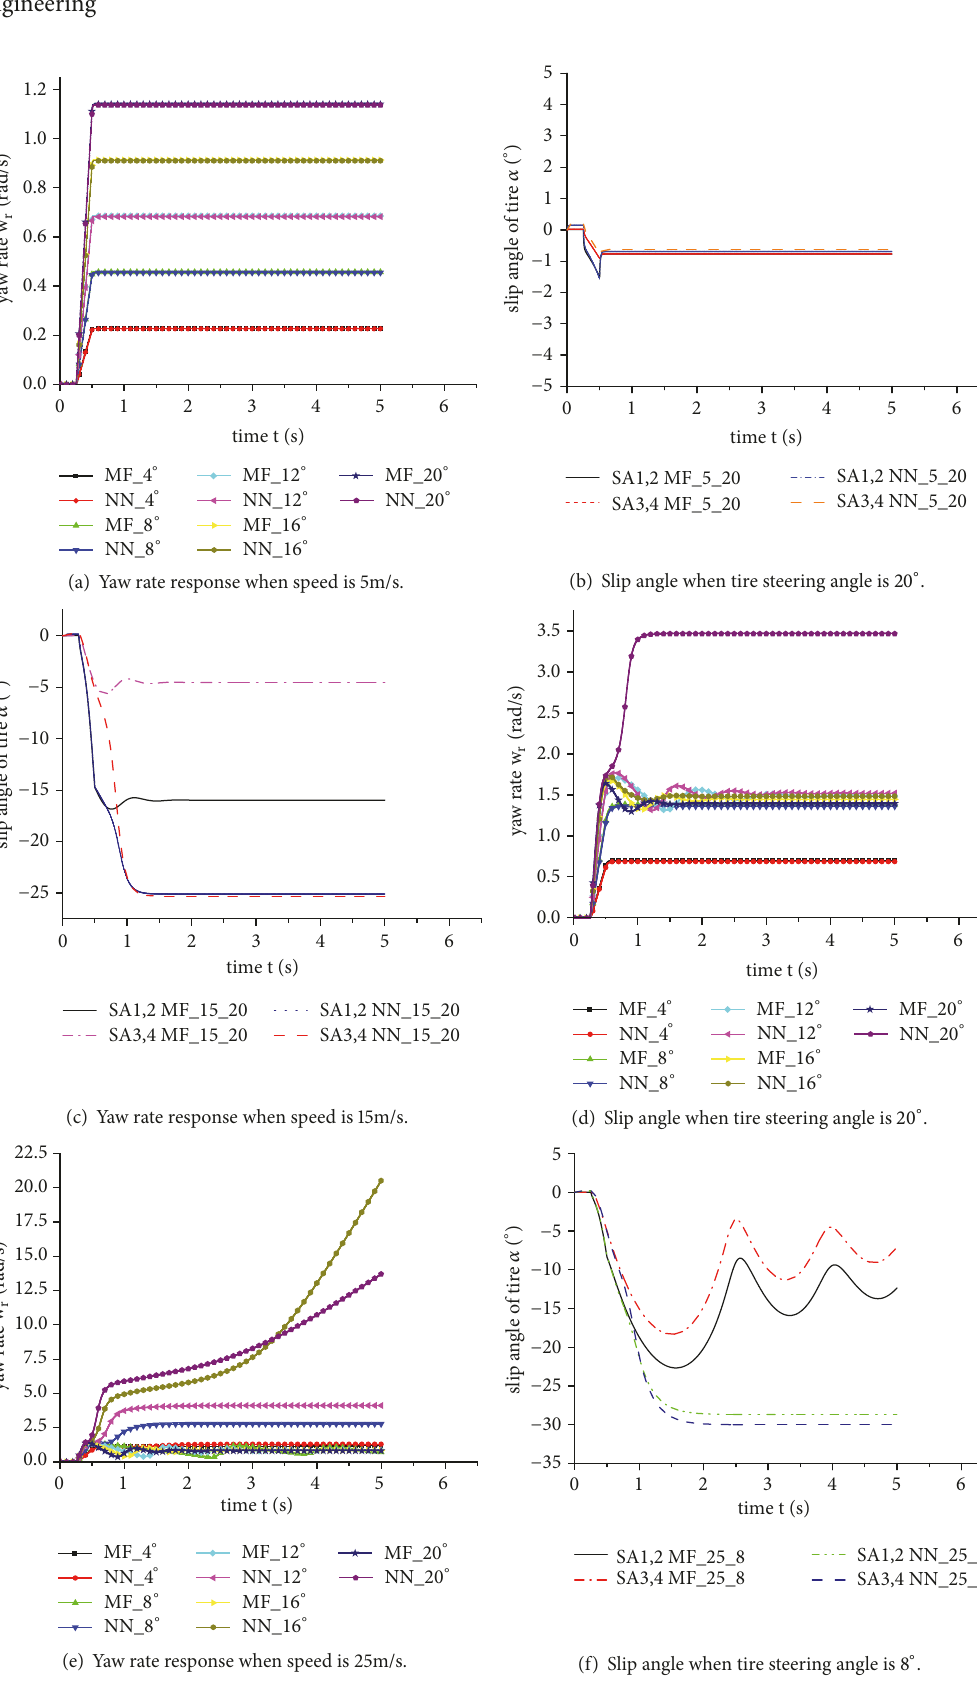
Figure 12: The comparison of simulation